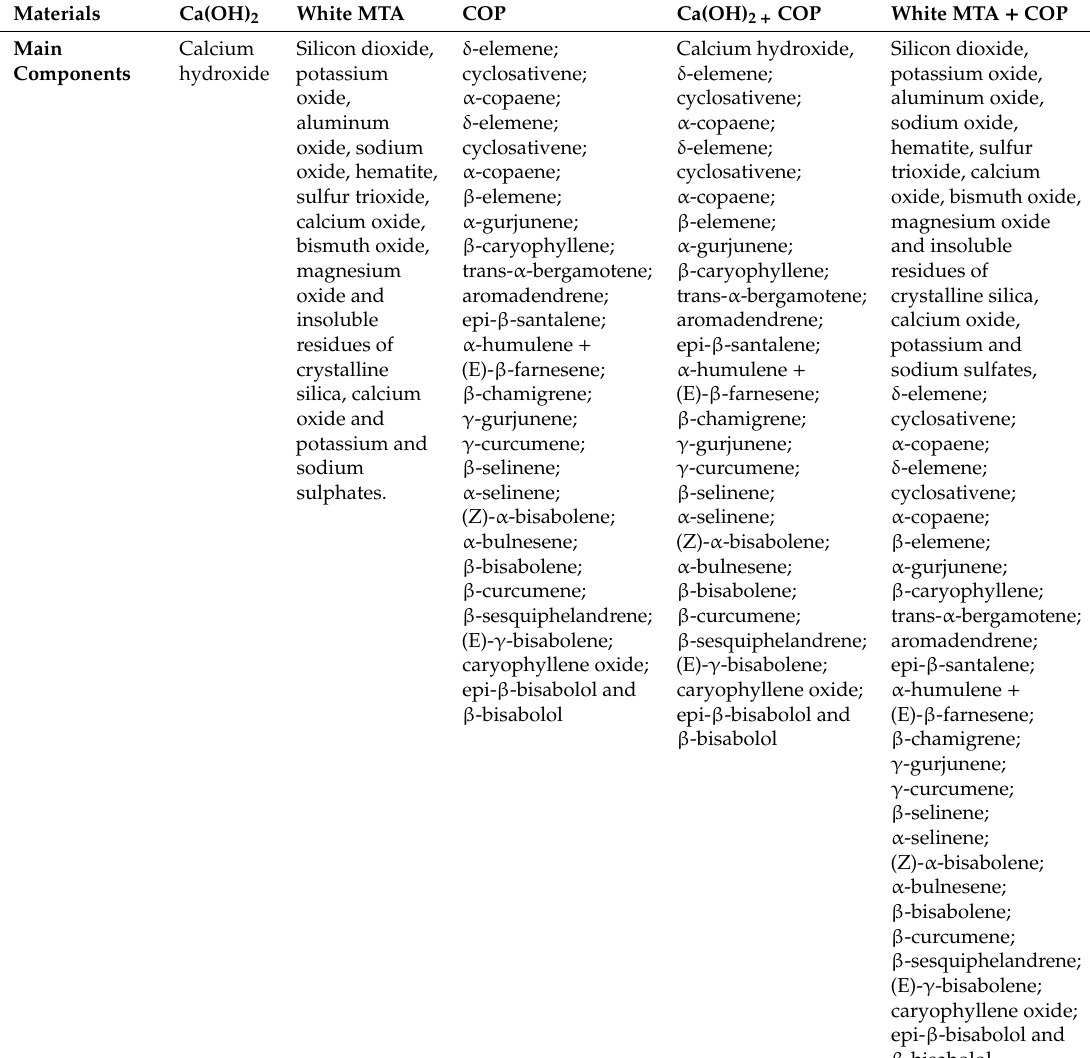
Table 1. Materials and associations used in this